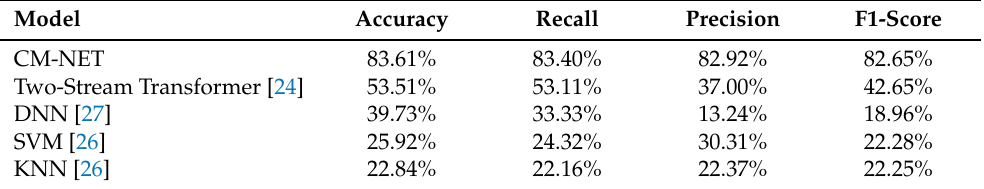
Table 4. Performance of existing networks on